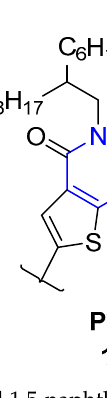
Figure 23. Fused 1,5-naphthyridine as optical DNA biosensor.